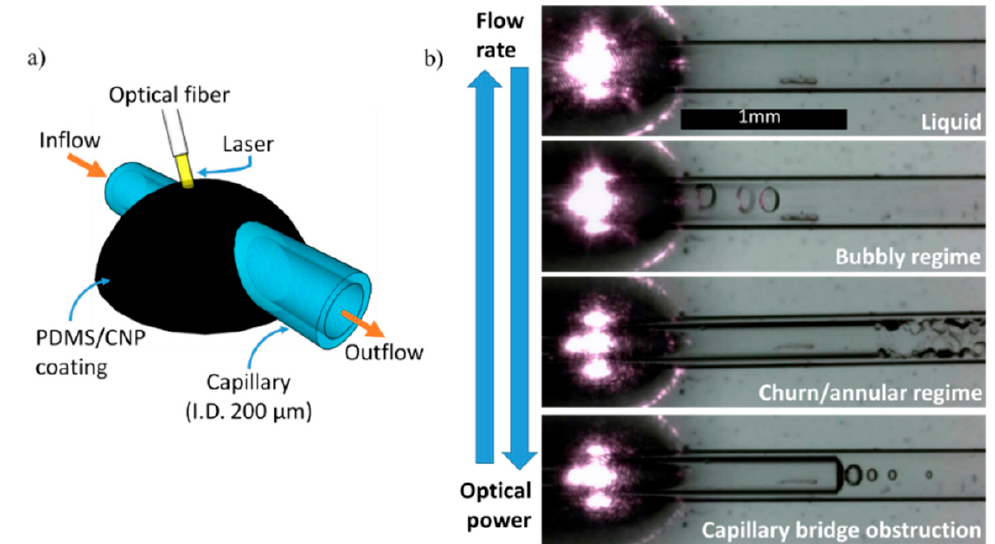
Figure 7. CNP/PDMS coatings for boiling flows: ( a ) schematic of the basic components to produce a boiling flow using PDMS+CNP coatings; ( b ) images showing the different flow regimes that can be achieved inside the capillary; the gas-liquid mixture can be varied by adjustments on the flow rate or the optical intensity of the laser diode. The bubbly flow regime constitutes the optimal flow condition since it allows good heat removal and optimal flow conditions. High optical powers or very low flow rates can create gas chambers or capillary bridges than can obstruct or introduce variations in the main